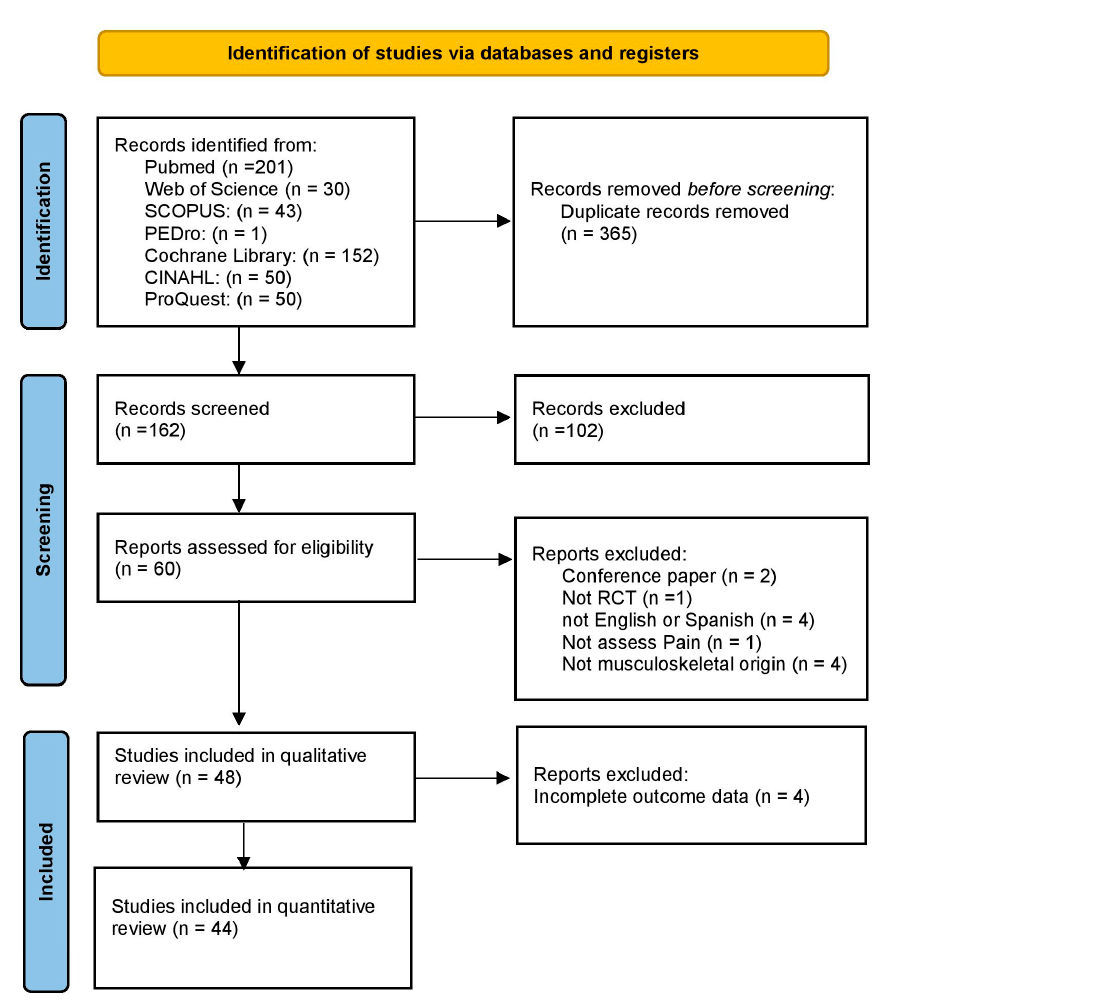
Figure 1. Flowchart of the systematic review and